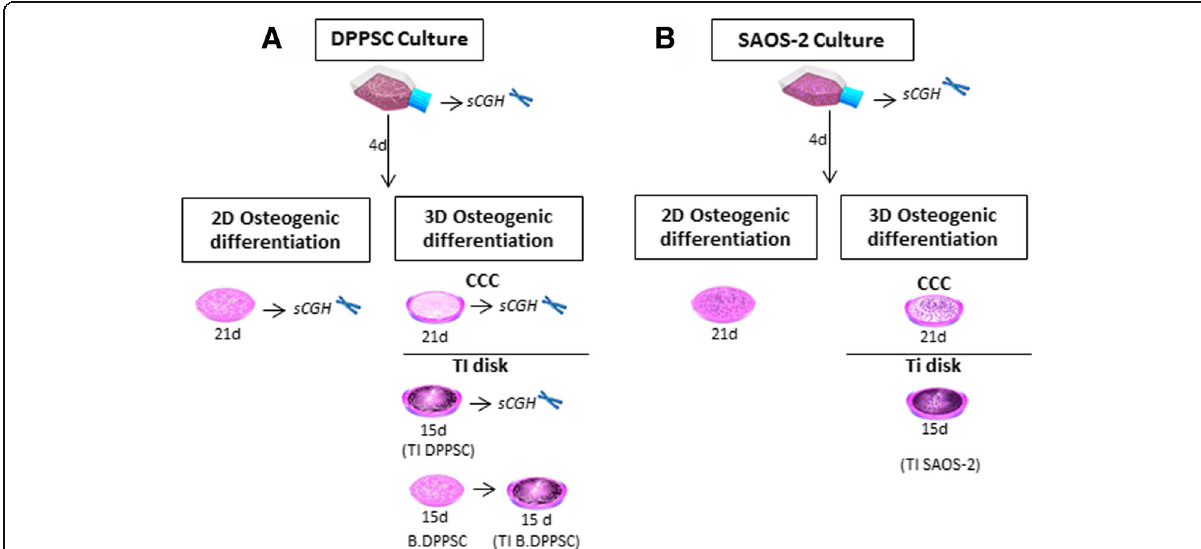
Fig. 1 Schematic diagram of the experimental design. a Osteogenic differentiation of DPPSC cultures. Undifferentiated DPPSC were cultivated during 15 passages, from 6 different donors. The genetic stability was checked at passages 1, 5, 10 and 15 by sCGH. 2D osteogenic differentiation: DPPSC from 3 of the 6 donors at P10 were differentiated during 21 days with osteogenic media in plastic culture plates. 3D osteogenic differentiation: DPPSC from 2 of the same donors (at passages 1, 5 and 10) used also in 2D differentiation were differentiated on biomaterials (CCC and Ti disks) during 21 and 15 days. DPPSC after 15 days of osteogenic 2D differentiation (B.DPPSC) were also seeded on titanium disks and maintained during 15 days more in osteogenic medium (TI B.DPPSC). sCGH was performed in all DPPSC differentiations. b SAOS-2 at P10 were used as a control cell line in all experiments. Genetic instability of SAOS-2 was evaluated before osteogenic induction experiments. DPPSC, Dental pulp pluripotent stem cells; SAOS-2, human osteosarcoma cell line; B.DPPSC, Bone-like DPPSC, differentiated 15 days in 2D conditions; TI DPPSC, DPPSC differentiated on titanium disks; TI B. DPPSC, Bone-like DPPSC differentiated on titanium disks; CCC, Collagen I-based Cell Carrier; TI disks, Ti6Al4V